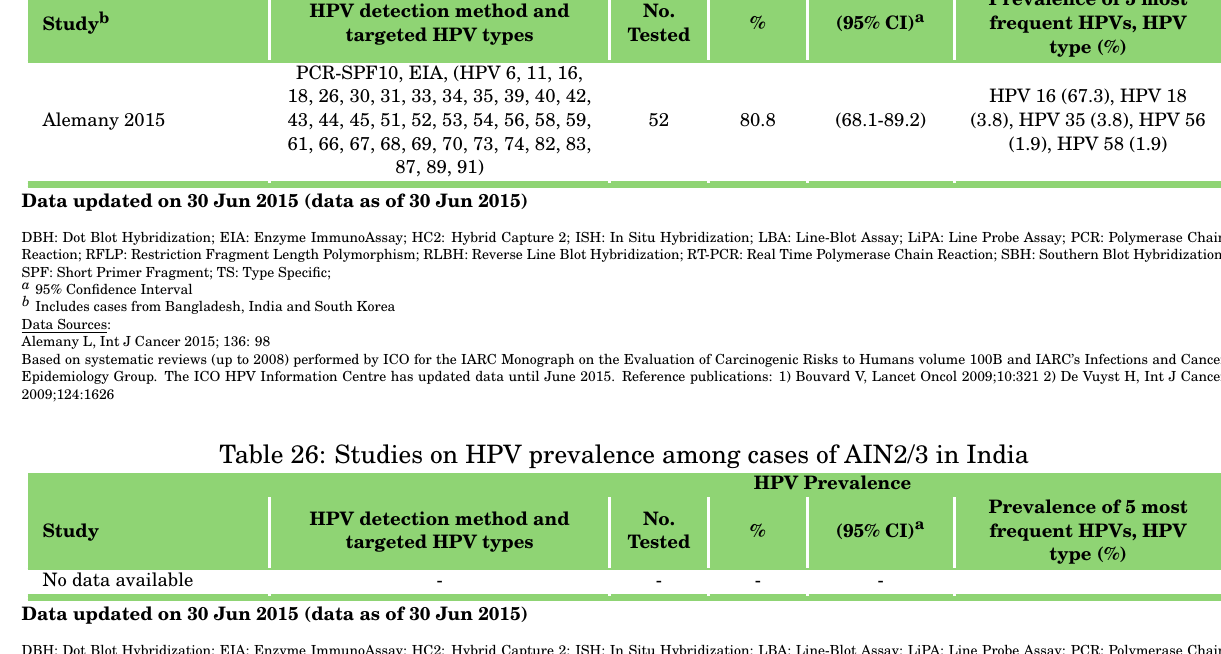
Table 25: Studies on HPV prevalence among anal cancer cases in India (male and female) Study b